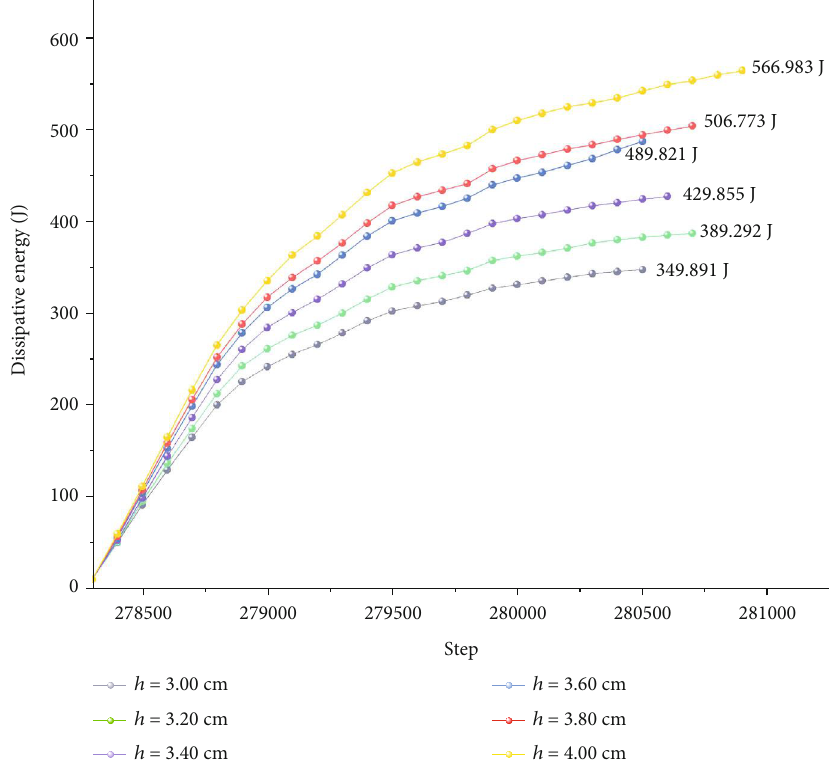
Figure 17: Variation diagram of dissipated energy under di ff erent drilling depth